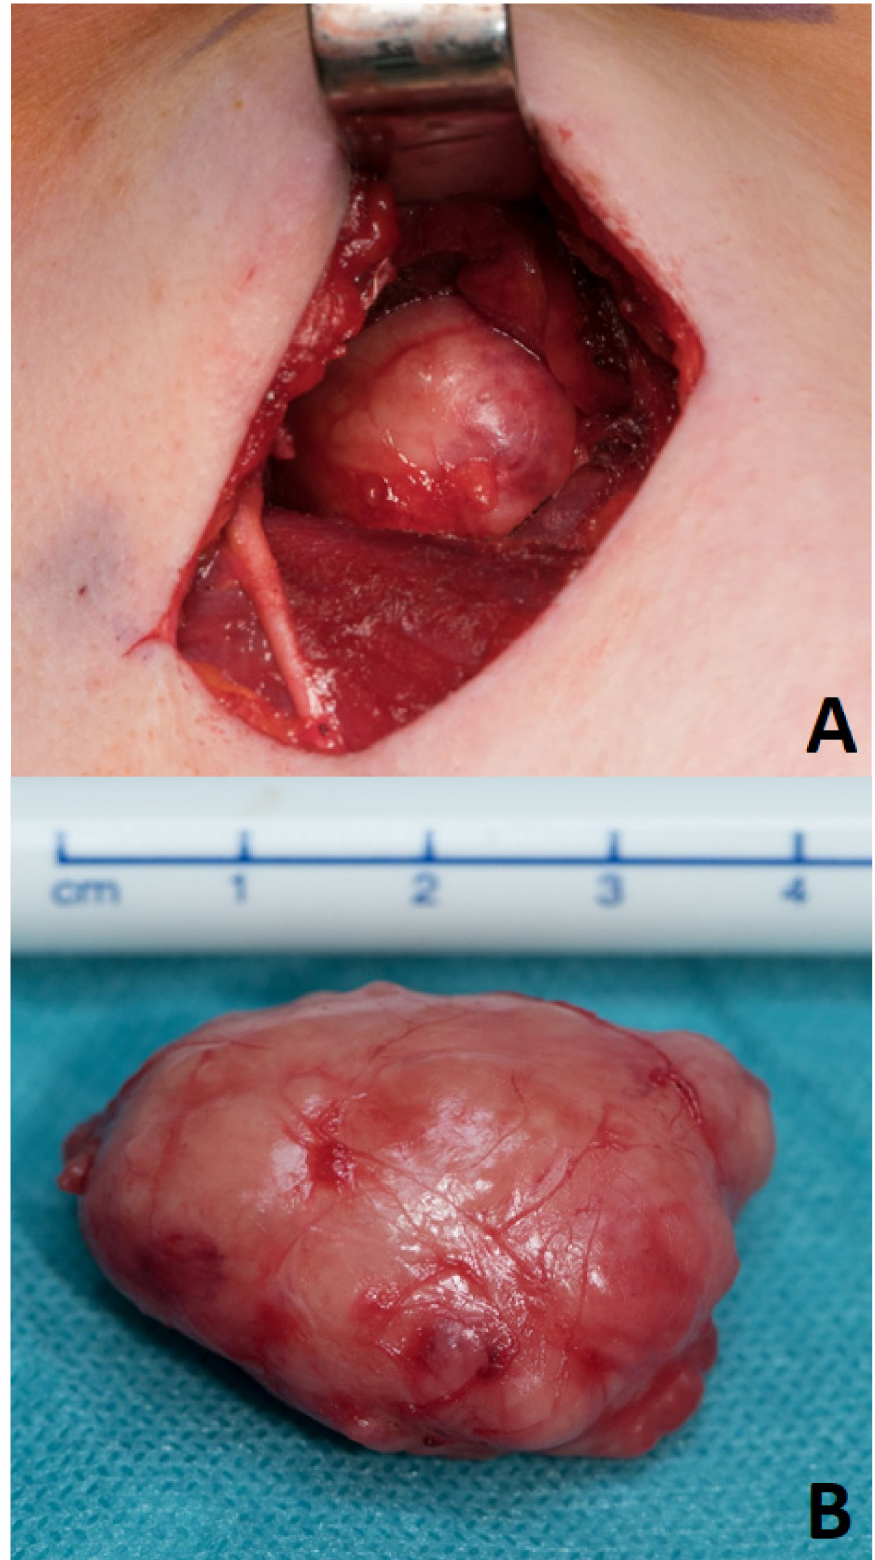
Figure 3. Parapharyngeal space: Transcervical capsular resection ( A ) of a pleomorphic adenoma ( B ). According to the current state of anatomic knowledge, there is no anatomic landmark that formally separates the PG into two lobes, as there is no soft tissue dissection